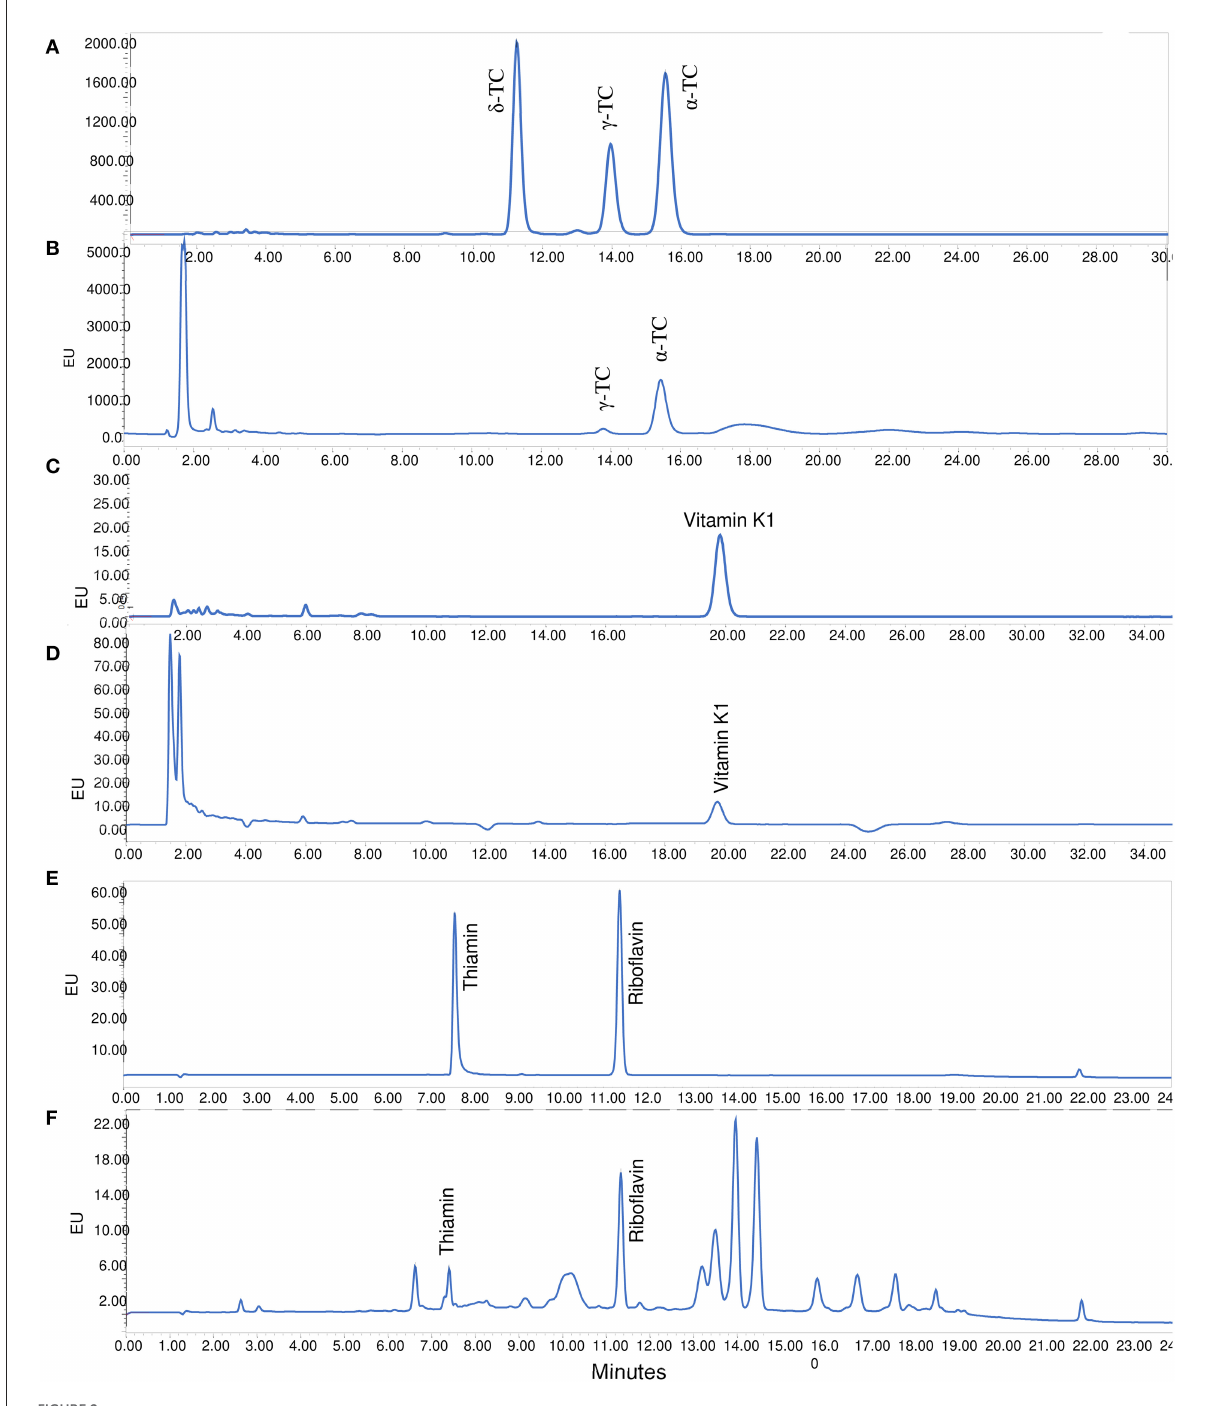
FIGURE2 Samples HPLC chromatograms. (A) Standards mixture of vitamin E or tocopherols; (B) tocopherols in basil; (C) standard vitamin K1 or phylloquinone; (D) phylloquinone in a basil; (E) Standards mixture of thiamin (B1) and riboflavin (B2); (F) B1 and B2 in a basil plant.